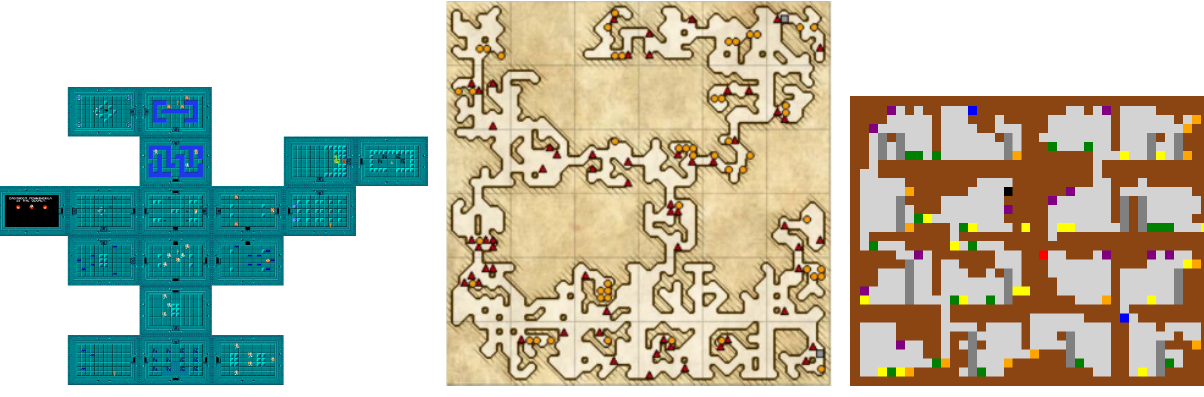
Figure 1. Types of 2D dungeon structures: top­down mansion­like (TDML), top­down cavern­like (TDCL), and side­scrolling (SS)